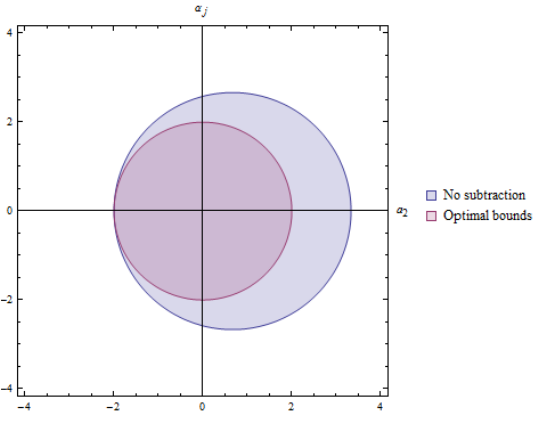
Figure 1 . Comparative study of